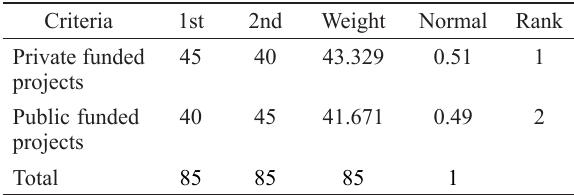
Table 9. Sources of funding that allow an SME to maximise rewards and minimise risks